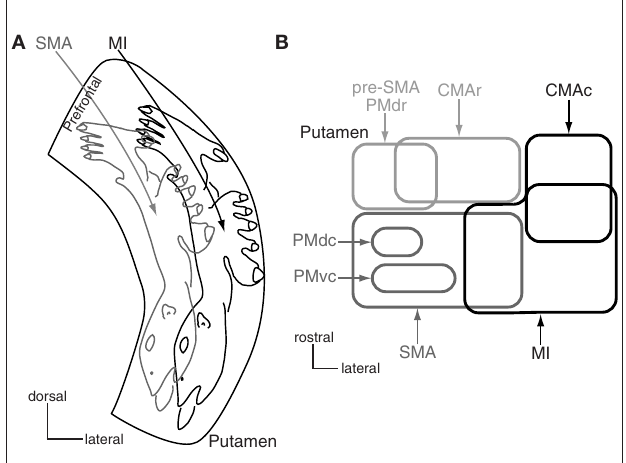
Figure 3 | Somatotopy of the putamen. (A) Somatotopy of the putamen is schematically shown in a frontal section. In the caudal aspect of the putamen, the lateral part receives somatotopic inputs from the primary motor cortex (MI), and the medial part from the supplementary motor area (SMA). The somatotopy in the SMA territory is located dorsomedially to that in the MI territory. Projections from the orofacial, forelimb and hindlimb regions of the MI and SMA converge in the medio-lateral central zone in the putamen. The most dorsomedial part receives inputs from the prefrontal cortex. Modified from Nambu et al. (2002a) (B) Input from motor cortices to the putamen is schematically shown in a horizontal section. CMAc and CMAr, caudal and rostral parts of the cingulate motor area; PMdc, PMdr, and PMvc, caudal part of dorsal premotor cortex, rostral part of dorsal premotor cortex, and caudal part of ventral premotor cortex. Modified from Takada et